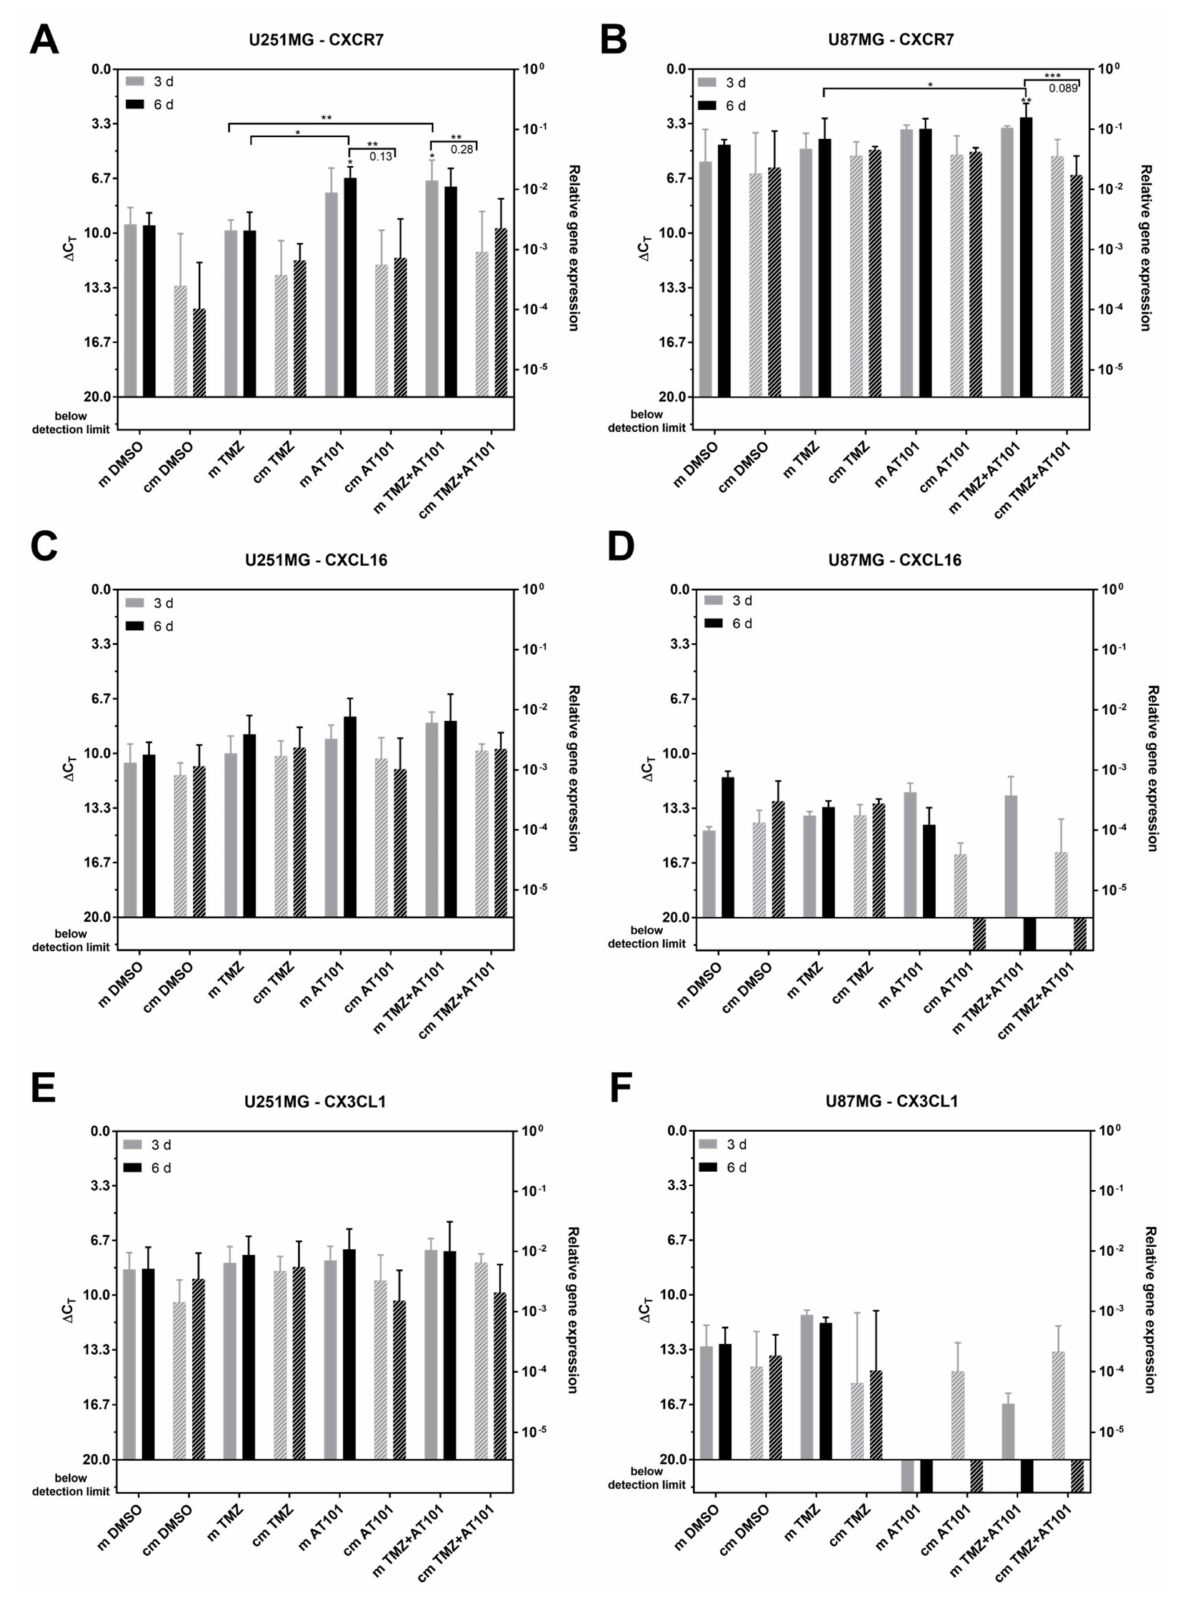
Figure 7. Chemokine (C-X-C motif) receptor 7 (CXCR7) was significantly less upregulated upon AT101 and TMZ plus AT101 treatment with stem-like cell conditioned media in comparison to the control medium. qPCR analysis of the mRNA expression of the chemokine receptor CXCR7 and the transmembrane ligands CXC ligand 16 (CXCL16) and chemokine (C-X3-C motif) ligand 1 (CX3CL1) in native U251MG and U87MG cells after stimulation with control medium (m) or